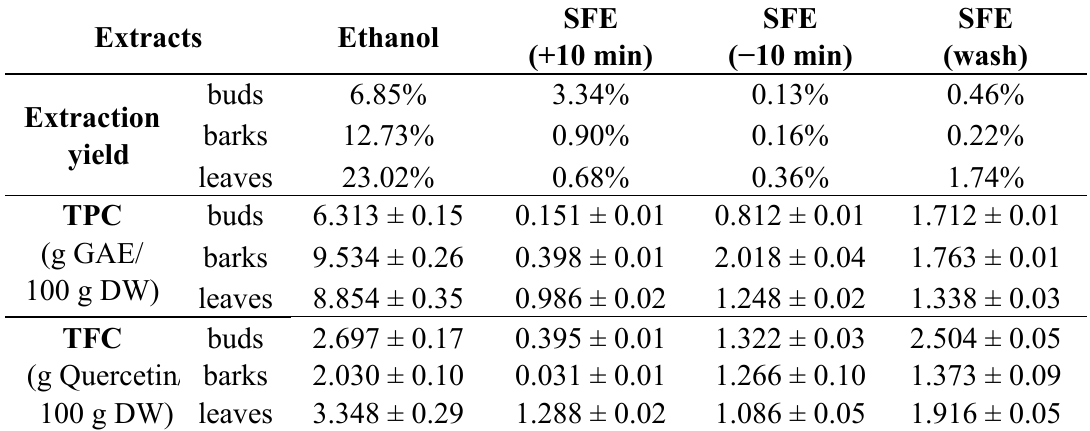
Table 1. Total phenolics (TPC) and flavonoids (TFC) in the various extracts of C. cassia.